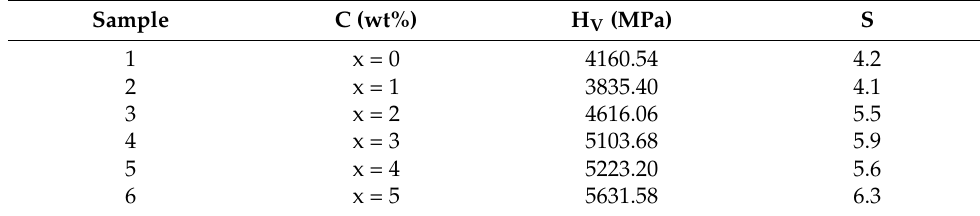
Table 3. Hardness and stress exponent value at 5 sec and load 100